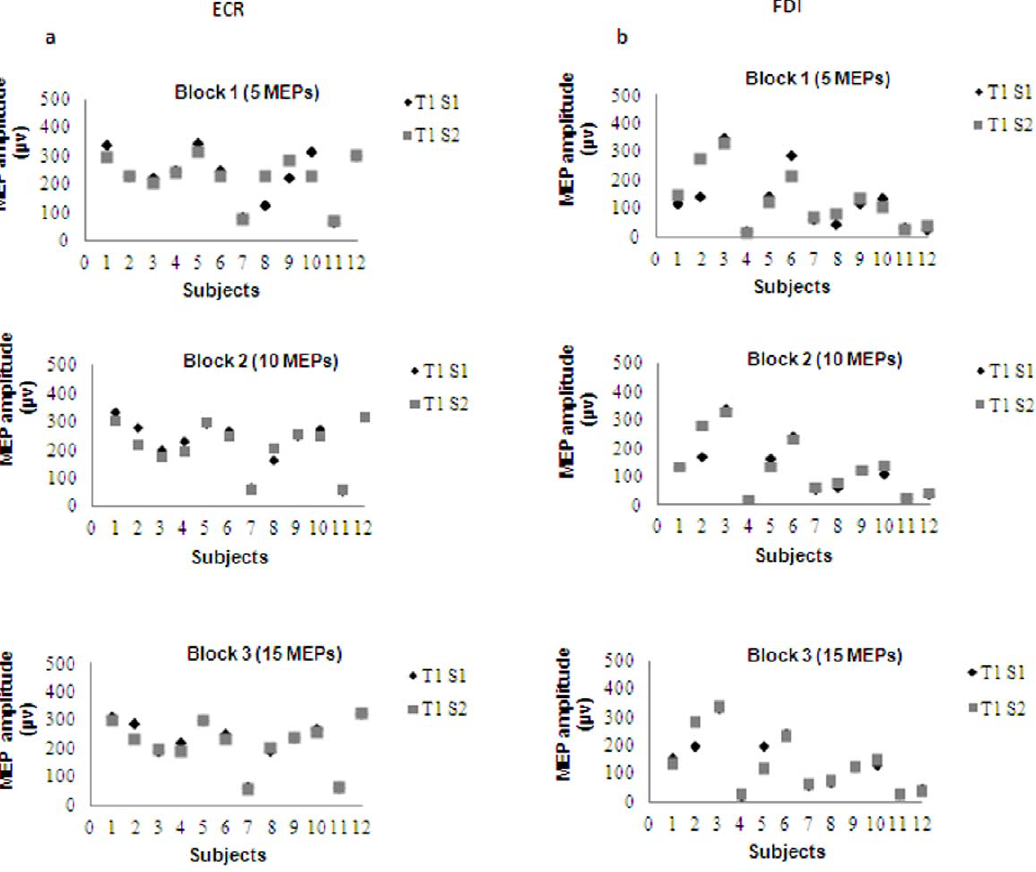
Largest ICCs values of each comparison are in bold. ECR: extensor carpi radialis; FDI: first dorsal interosseus; ICCs: inter class correlations; SEM: standard error of measurement.